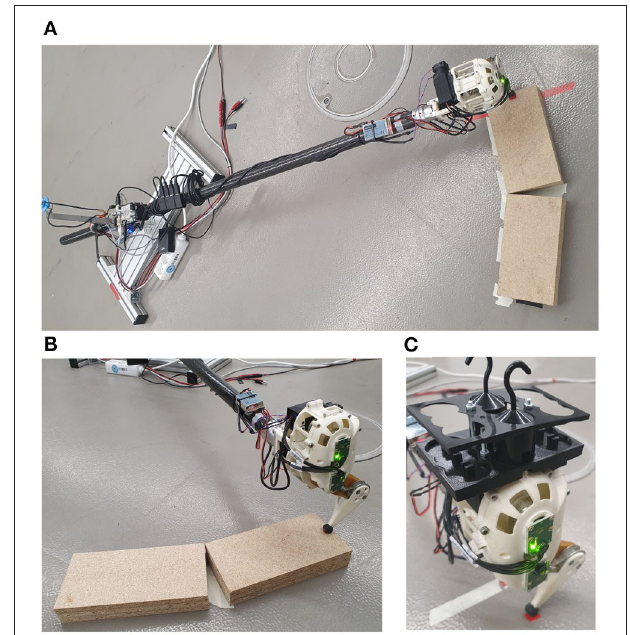
FIGURE 2 | (A) In the experimental hardware setup, the robotic hopper is attached to a boom to realize the floating base. (B) In the fall scenario the hopper is initialized on a plateau. The gap between the plateau pieces did not cause any disturbance. (C) For the analysis of energy efficiency, an increasing load in form of weights is attached to the